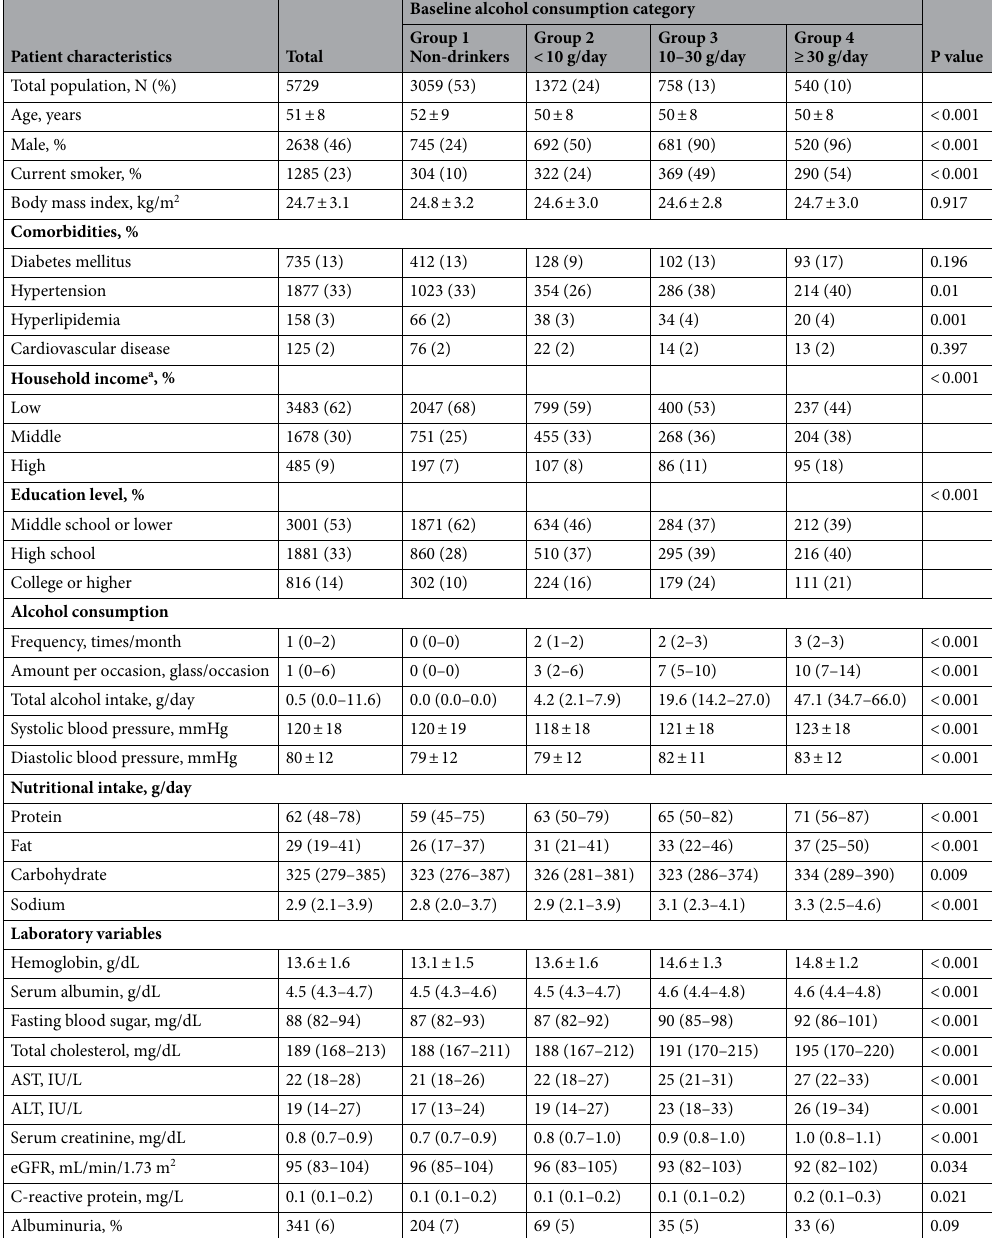
Table 1. Baseline characteristics of 5729 participants according to groups defined by baseline alcohol consumption. AST aspartate aminotransferase, ALT alanine aminotransferase, eGFR estimated glomerular filtration rate. SI conversion factor: to convert hemoglobin from g/dL to g/L multiply by 10; to convert serum albumin in g/dL to g/L, multiply by 10; to convert creatinine to μmol/L, multiply by 88.4; to convert total cholesterol from mg/dL to mmol/L multiply by 0.0259. Values for categorical variables are shown as No. (%); values for continuous variables, as mean ± standard deviation or median (interquartile range). a Household income was categorized into three groups; < 2,000,000 Korean won (KRW) per month (low), 2,000,000 to < 4,000,000 KRW per month (middle), and ≥ 4,000,000 KRW per month